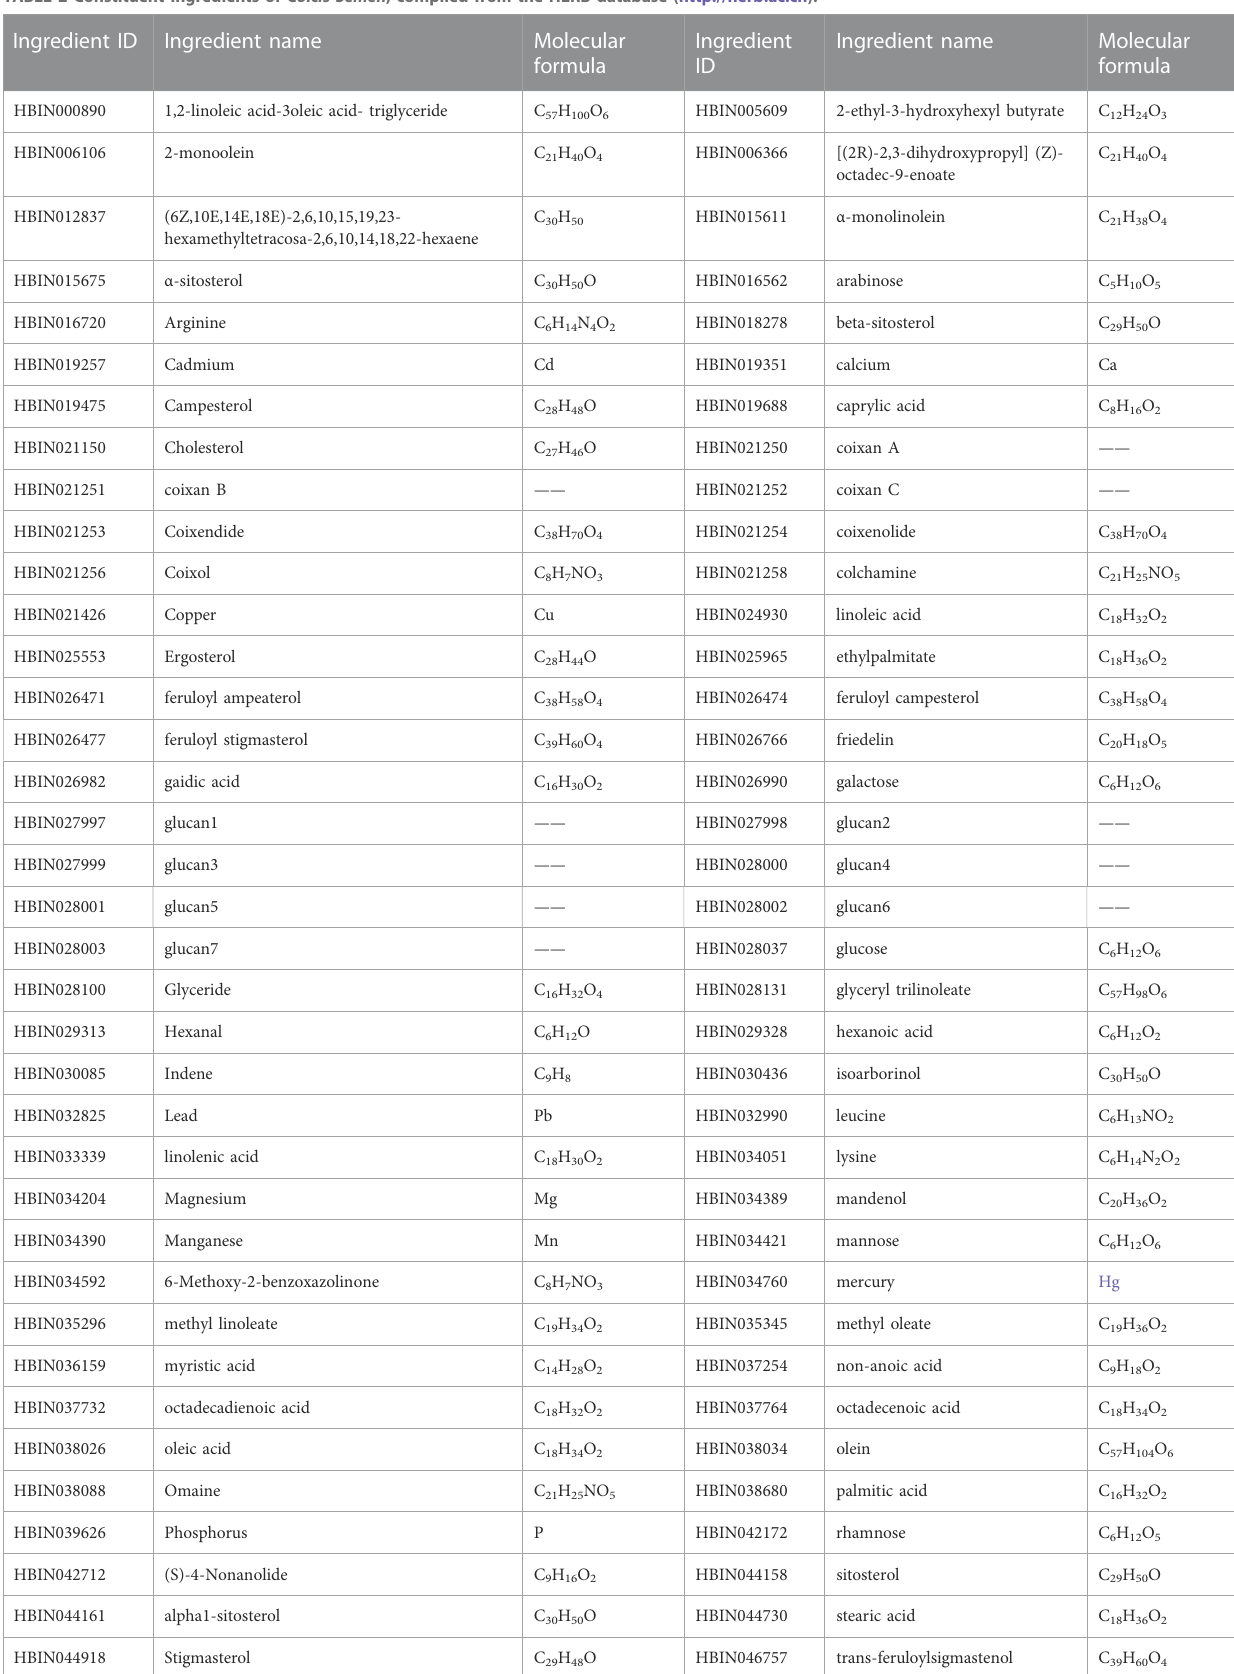
TABLE 2 Constituent ingredients of Coicis Semen , compiled from the HERB database